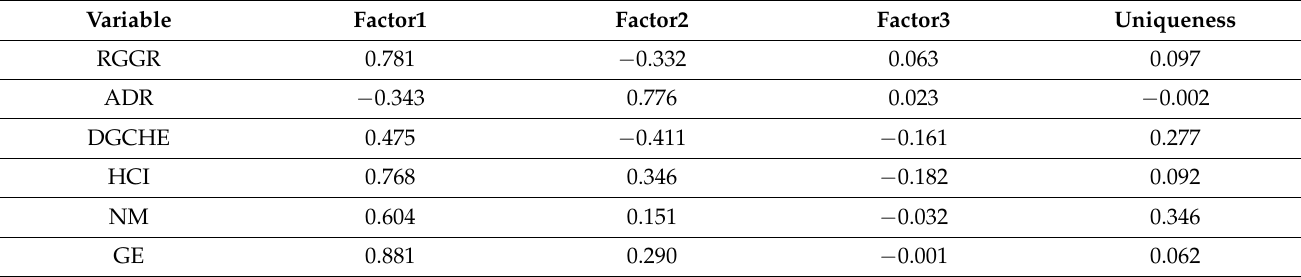
Table 3. Factor loadings (pattern matrix) and unique